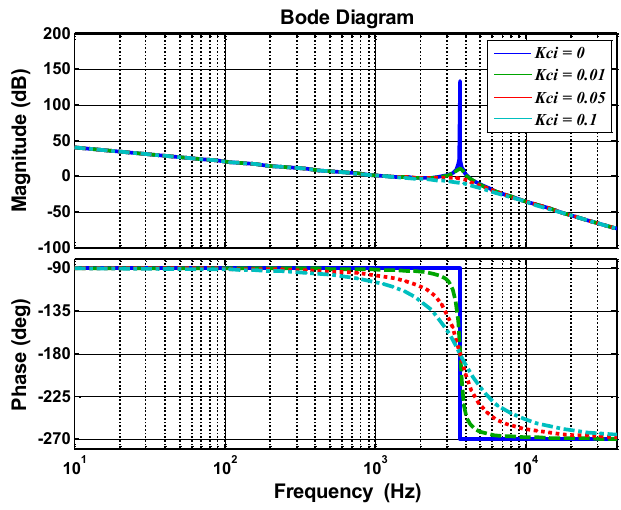
Figure 9. System with no PR controller: Bode